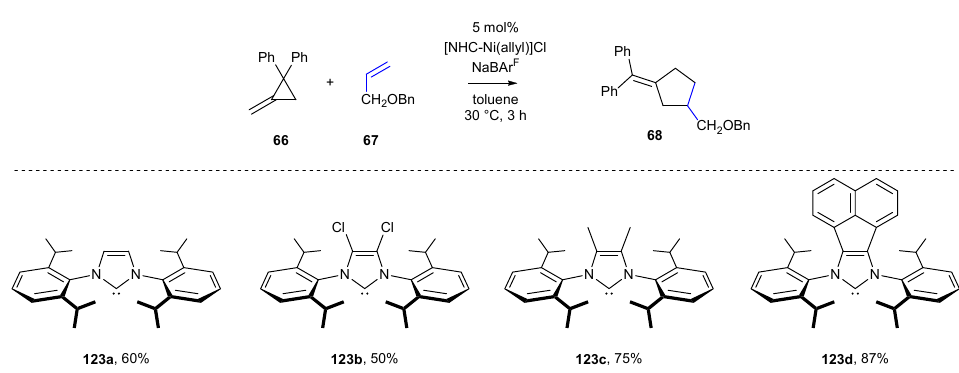
Scheme 54. Influence of backbone modification of NHC ligands on cross-dimerization of methylene cyclopropanes with alkynes.